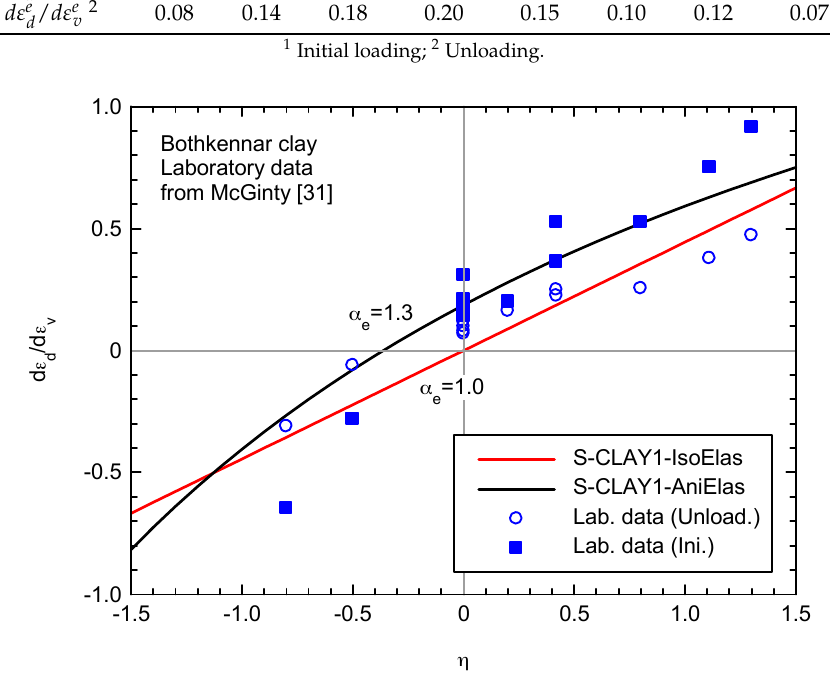
Figure 5. Variation of strain path direction with stress ratio (Ini.: initial loading; Unload.: unloading).